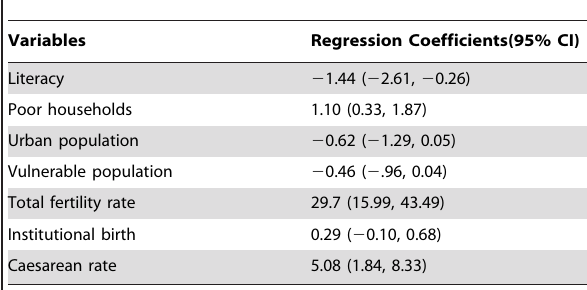
Table 3. Regression model assessing correlates of